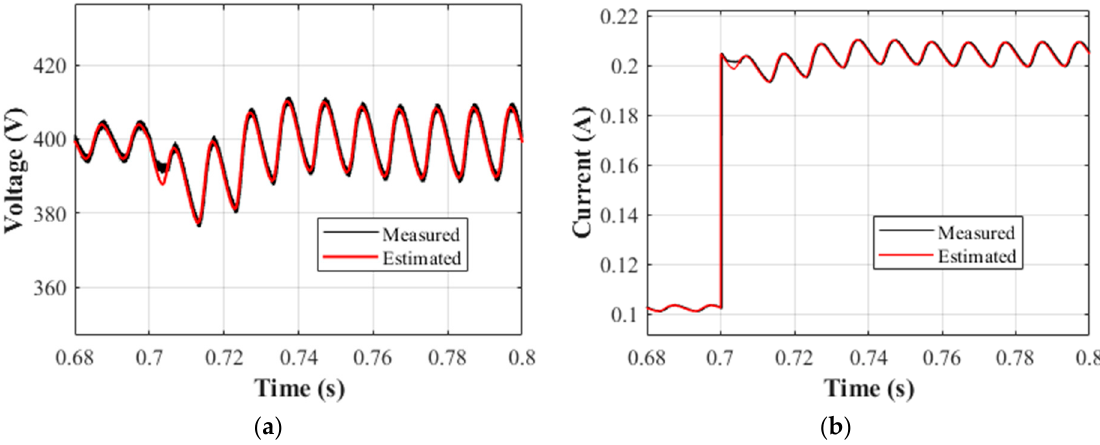
Figure 16. Measured and simulated transient response of the boost PFC. ( a ) Input voltage. ( b ) Input current.